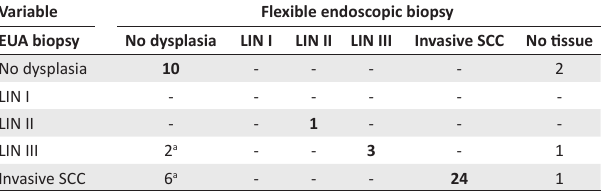
TABLE 1: Flexible endoscopic biopsy versus examination under general anaesthesia biopsy. Variable